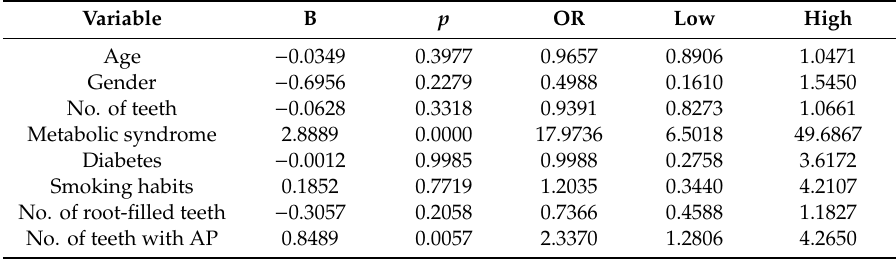
Table 3. Multivariate logistic regression analysis of the influence of the independent variables of age, gender (0 = women, 1 = male), number of teeth, metabolic syndrome (0 = absent, 1 = present), diabetes (0 = absent, 1 = present), smoking habits (0 = non-smoker, 1 = smoker), number of root-filled teeth, and number of teeth with apical periodontitis on the dependent variable “cardiovascular events” (0 = absent, 1 = present). Variable B p OR Low High Age − 0.0349